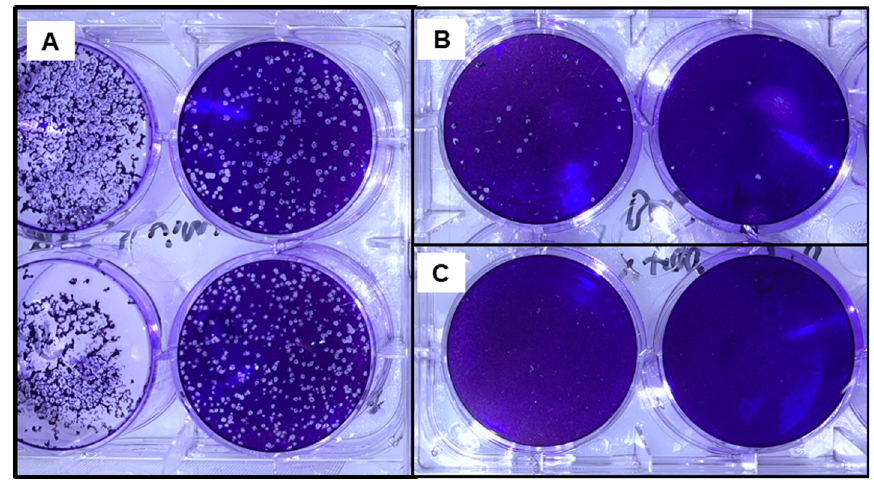
Fig 1. Monkeypox viral titers in whole blood products pre- and post- treatment with Mirasol. Plaque assay results from monkeypox virus pre- and post- inactivation with UV light and riboflavin. Assay performed on 6-well cell culture plates and cells stained with crystal violet for plaque visualization. A) Virus stock. B) Virus with riboflavin prior to inactivation. C) Post- inactivation.